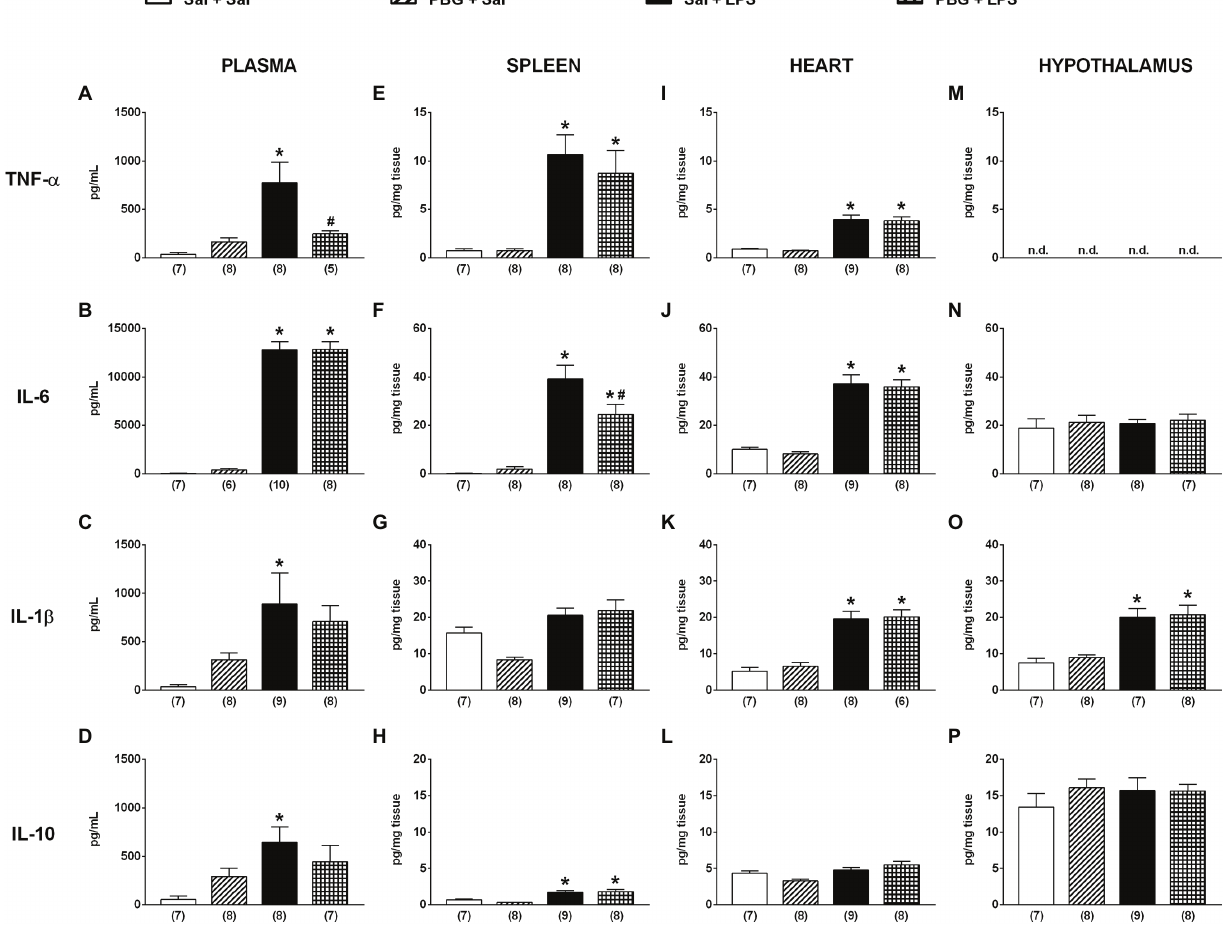
FIGURE 3 | Bezold-Jarisch reflex activation decreased the release of TNF- α induced by LPS in plasma and IL-6 in the spleen. Bar graphs show the levels of TNF- α , IL-6, IL-1 β , and IL-10 in plasma (A - D) , spleen (E - H) , heart (I - L) , and hypothalamus (M - P) 90 min after the administration of LPS or saline in the different groups. IL-6, interleukin 6; IL-1 β , interleukin 1 β ; IL-10, interleukin 10; LPS, lipopolysaccharide; n.d, not detected; PBG, phenylbiguanide; Sal, saline; and TNF- α , tumor necrosis factor-alpha. * p < 0.05 vs. Sal + Sal group; # p < 0.05 vs. Sal + LPS group. One-way ANOVA with Tukey’s post-hoc test. The number in parentheses represents the number of samples of each